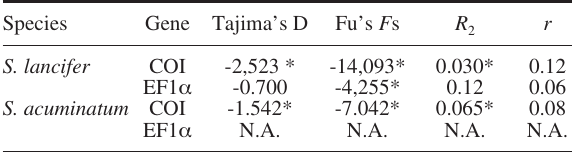
Table 2. – Results of selective neutrality tests and Harpending’s Raggedness index, for COI and EF1 α sequence data of S. lancifer and S. acuminatum . In the case of S. acuminatum lack of variation at the nuclear level prevented the determination of these estimates. * indicates significant values ( P